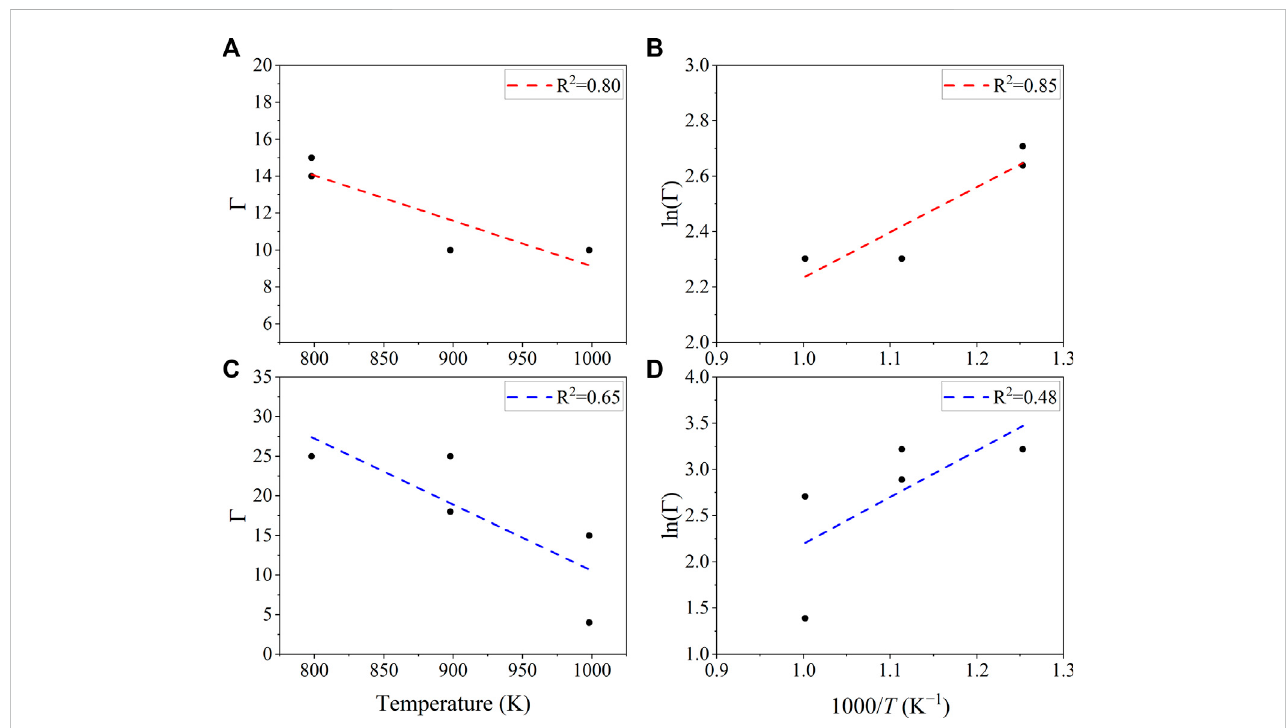
FIGURE 2 Accommodation coef fi cient as a function of temperature for argon in NaCl-MgCl 2 , (A,B) and xenon in NaCl-MgCl 2 (C,D) The accommodation coef fi cients decrease with temperature (A,C) . The enthalpy can be calculated from ln( Γ ) vs. 1/ T